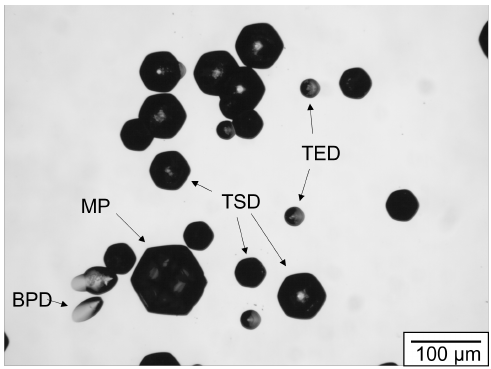
Figure 15. Microscopic image of typical etch pits in a 4H/6H-SiC wafer, etched with